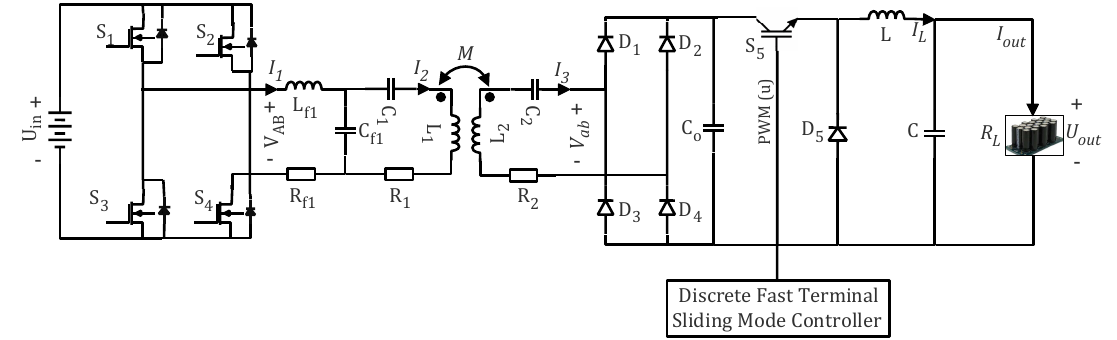
Figure 3. Circuit diagram of the proposed WPT